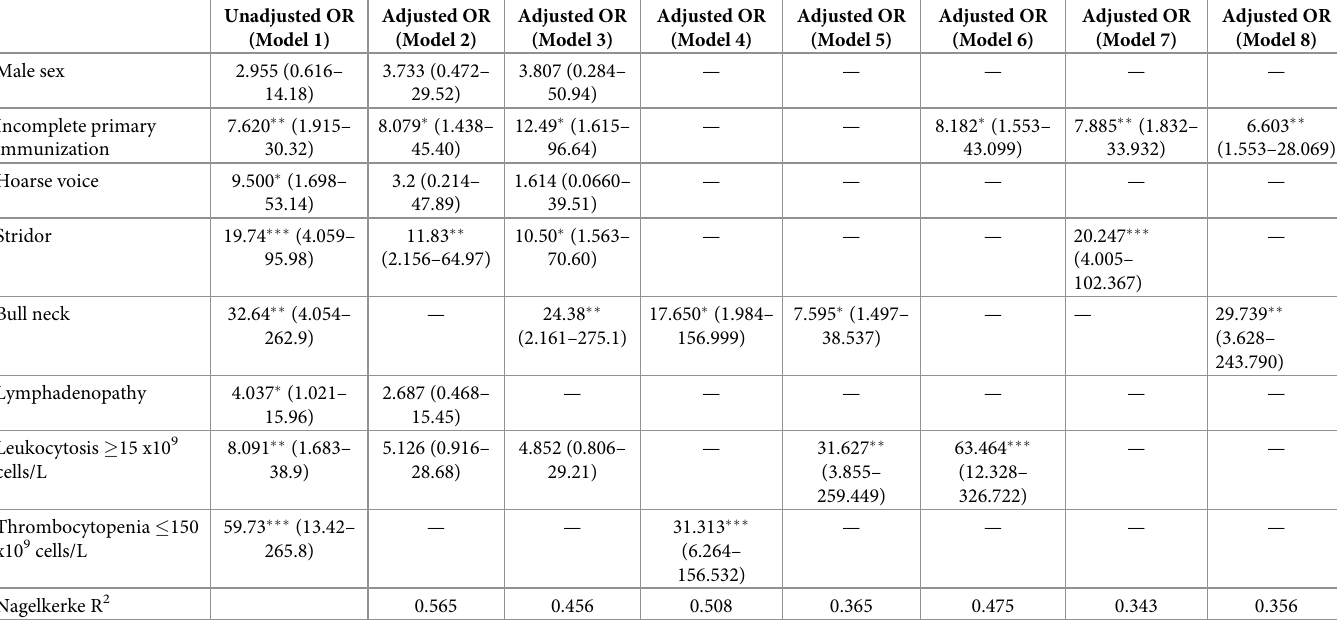
Table 4. Unadjusted (Model 1) and adjusted (Models 2–8) odds ratios as determinants for death in clinical diphtheria. Unadjusted OR (Model